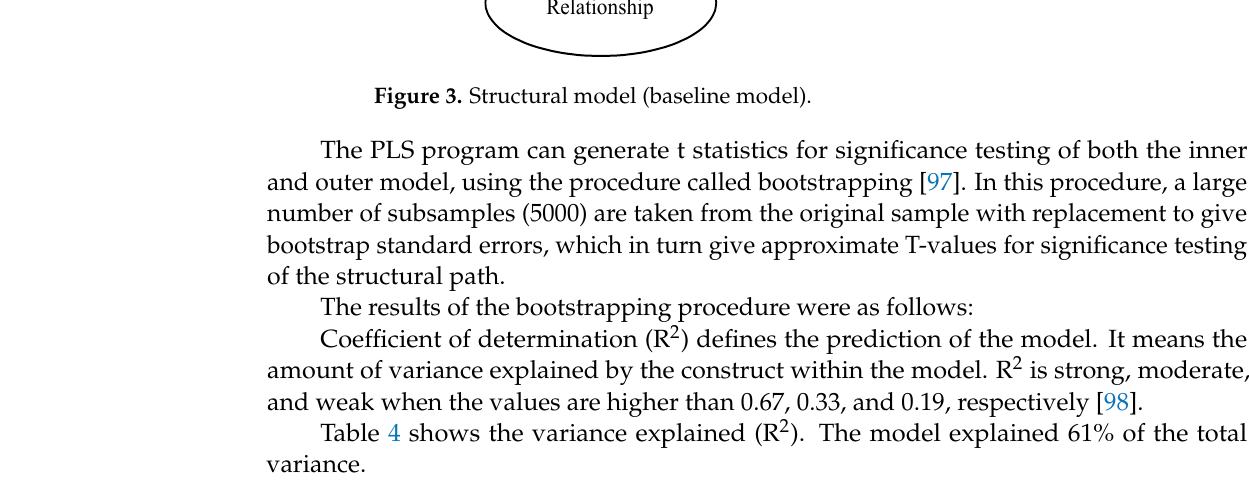
Figure 3. Structural model (baseline model).